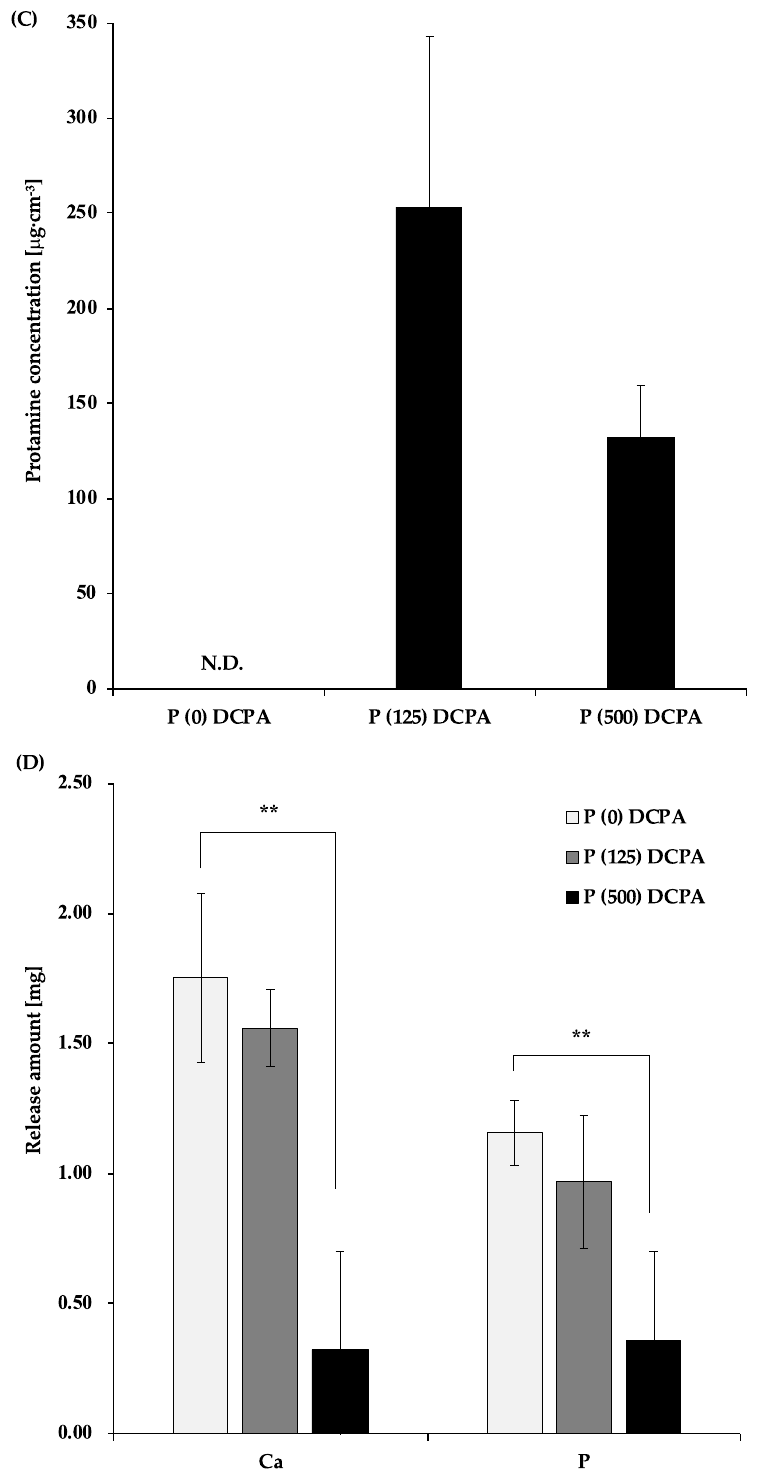
Figure 4. Analysis of the supernatants of the fabricated discs. The supernatants of the discs were explored after incubation of S. mutans in culture containing 1% sucrose for 24 h. Error bars indicate the standard error of the mean ( n = 3). The asterisks show * p < 0.05, ** p < 0.01 by Student’s t -test. ( A ) S. mutans cells in supernatant were evaluated by colony counting on an agar plate at 48 h post-infection. ( B ) The pH value of the supernatant was measured by a pH meter. ( C ) Protamine concentration in supernatant was quantified by Bradford assay. ( D ) Calcium and phosphate release from the discs were quantified by ICP-AES.